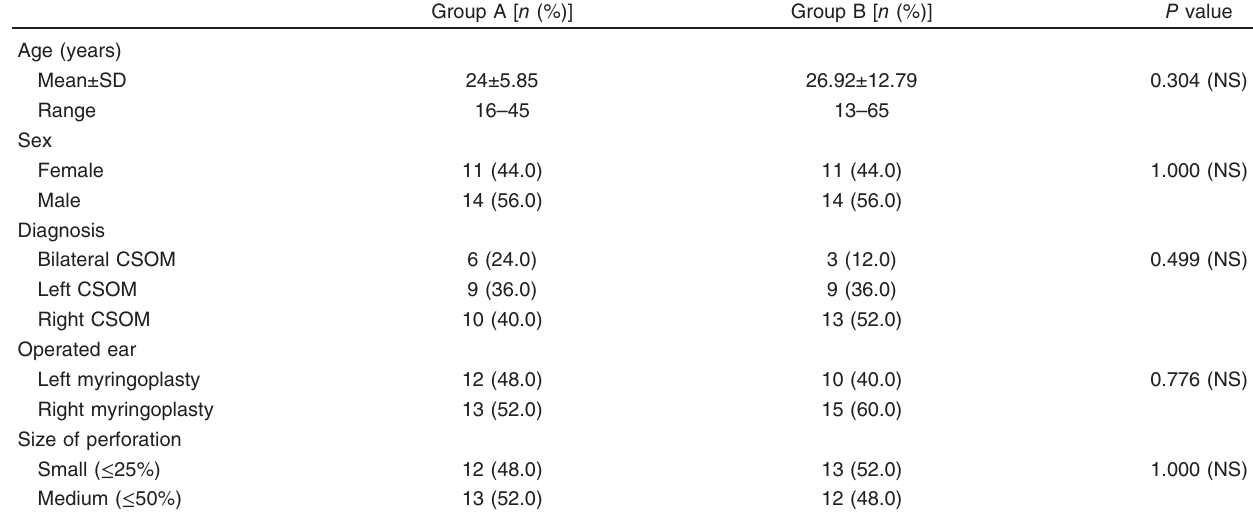
Table 1 Baseline characteristics of patients in both groups